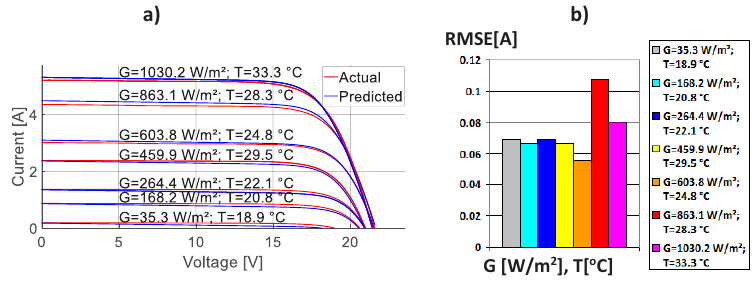
Figure 7. Comparison between the calculated (proposed model) and experimental curves of operation conditions of single-crystalline Cocoa xSi12922 PV panel: ( a ) Graphical comparison; ( b ) RMSE of proposed model.